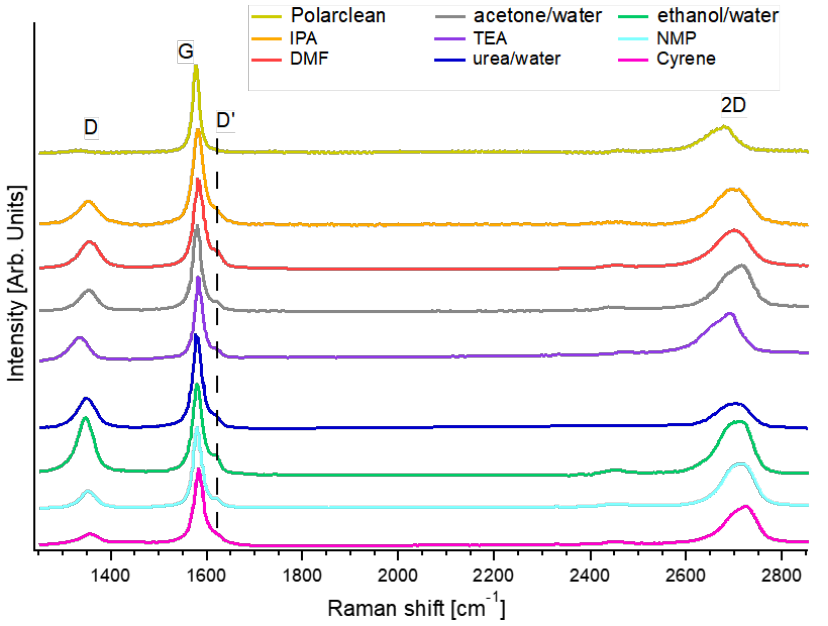
Figure 5. Comparison of the Raman spectrum for graphene exfoliated in the liquid phase with NMP [69], Cyrene [69], IPA [87], DMF [88], acetone/water [89], ethanol/water [90], TEA [63], and aqueous solution of urea [64], and Polarclean [70]. Data were taken from the above-mentioned references.